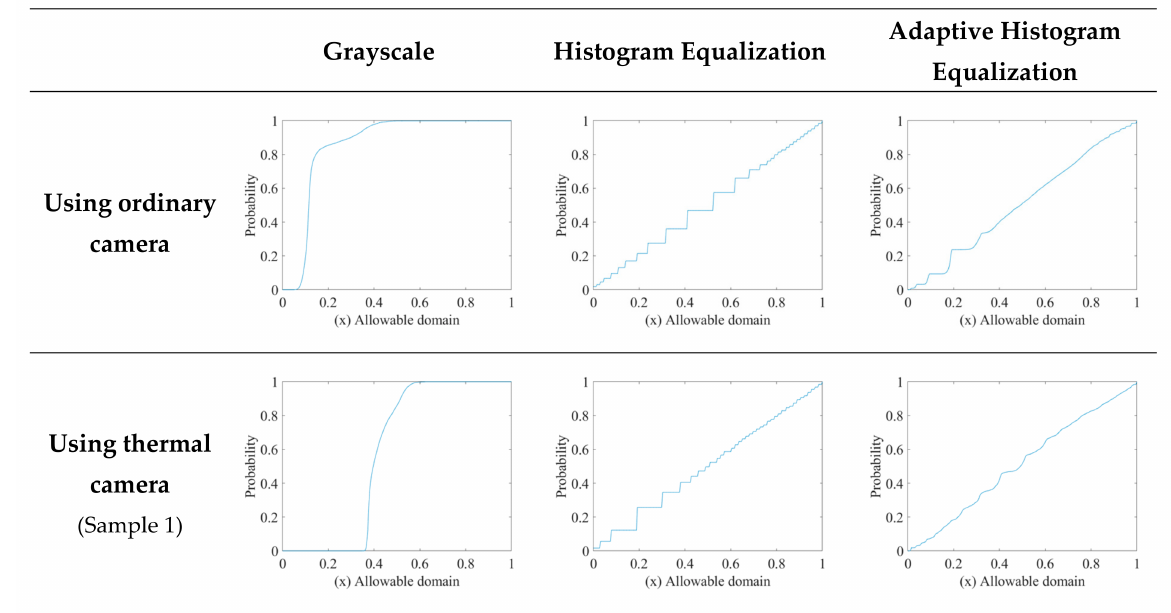
Figure 13. The CDF representation of the processed sample solar cell images was acquired both from the ordinary and thermal